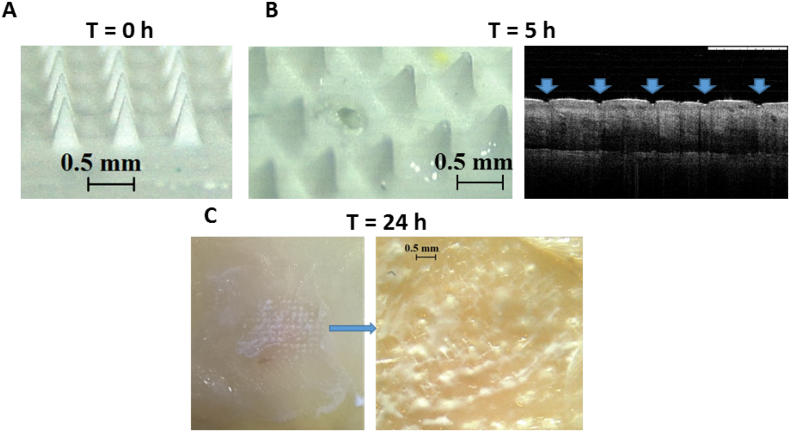
Representative digital micrographs illustrative of the dissolution of RPV LA MAP at specific time points (0, 5 and 24 h) in excised neonatal porcine skin. Digital micrograph of a RPV LA MAP prior to insertion into skin (A). Digital micrograph of a RPV LA MAP upon removal from the skin after an insertion time of 5 h and OCT image of the resulting microconduits in the porcine skin following MAP removal (B). Digital image and micrograph of porcine skin upon removal of RPV LA MAP post-24 h insertion with RPV LA visible in the microconduits which were created in the skin (C).